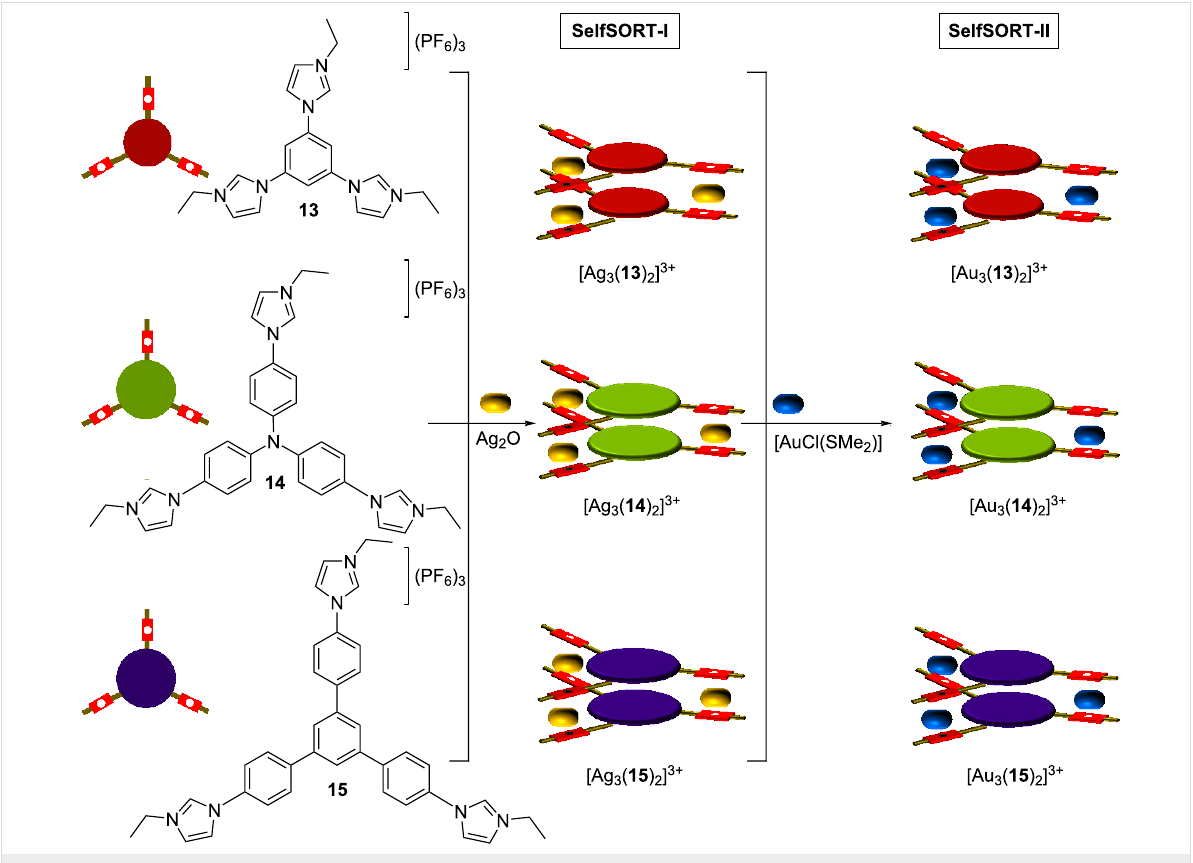
Figure 7: Exchange of Ag + for Au + ions in poly-NHC ligand-based organometallic